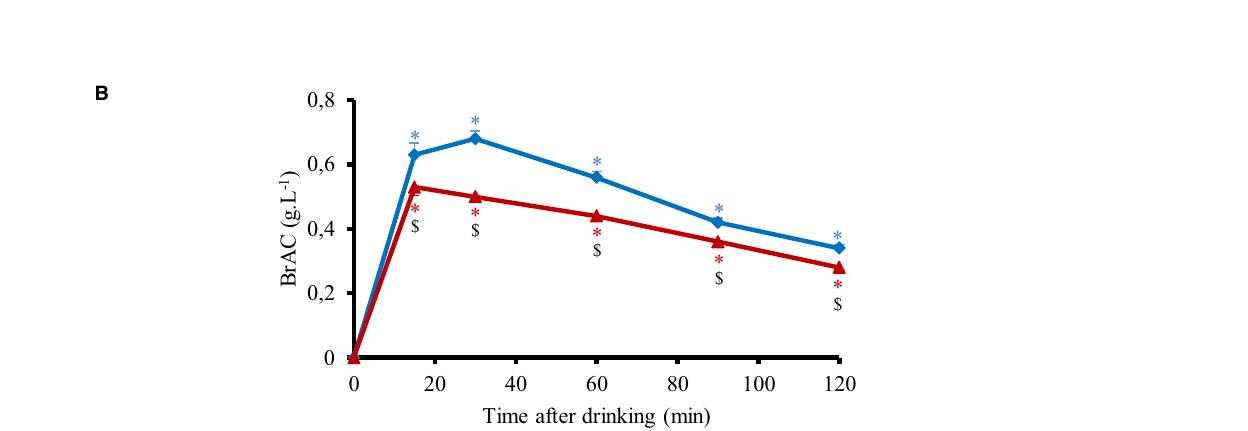
Figure 1B . BrAC at each time point and mean BrAC over the test (averaged from 30 to 120 min) were higher after drinking V compared to V + S (0.51 ± 0.01 g.L − 1 vs. 0.40 ± 0.01 g.L − 1 , respectively, p < 0.001). We did not observe any gender difference in BrAC. Correlation between mean BrAC over 30–120 min (BrAC 30 − 120min ) and anthropometric data are presented in Figure 2 . Mean BrAC 30 − 120min tended to be positively correlated to percent body fat in women after drinking V ( R ² = 0.31, p = 0.06) and V + S ( R ² = 0.29, p =